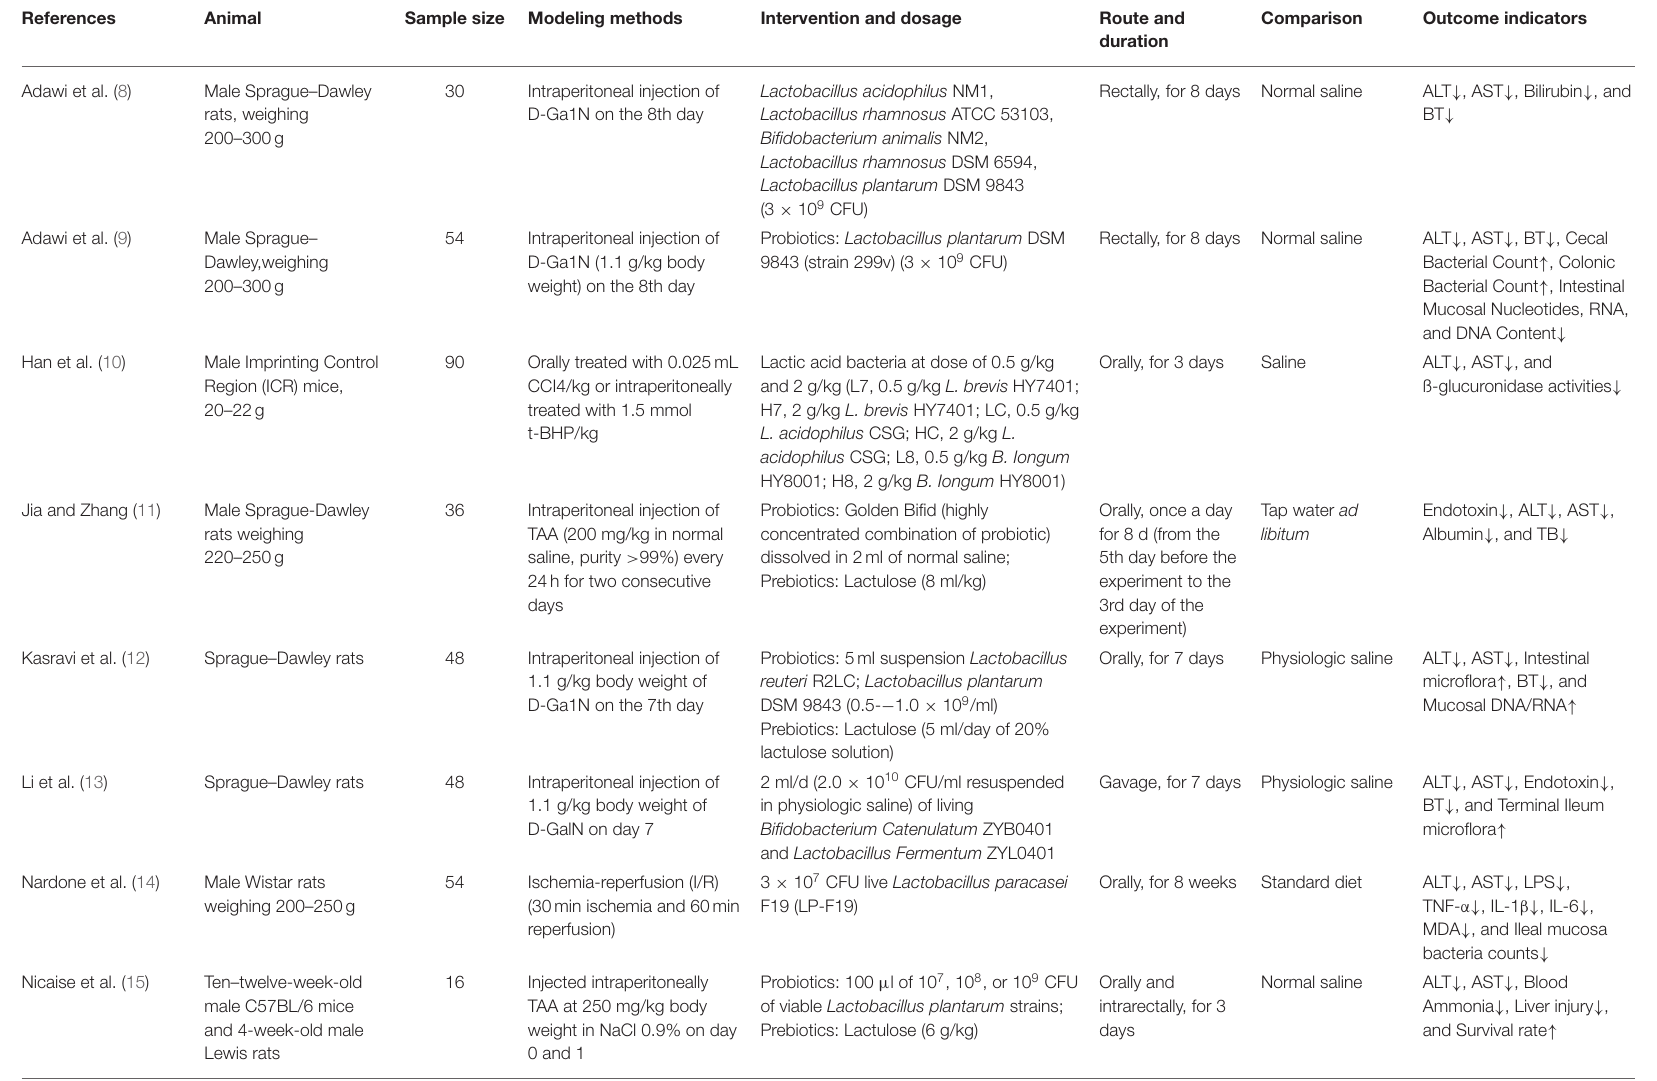
TABLE 1 | Characteristics of included studies investigating the effects of probiotics or prebiotics on